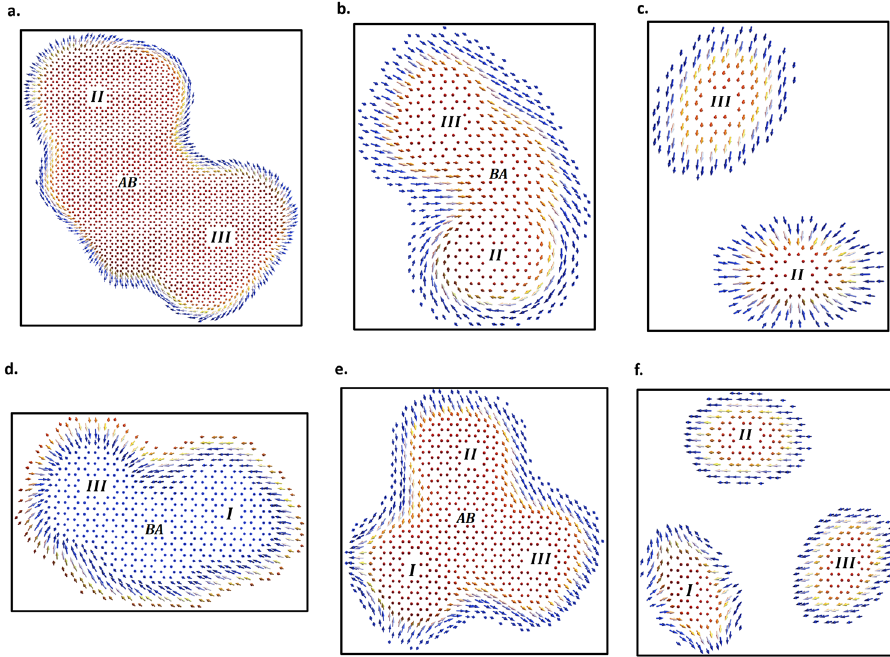
Fig. 4 Merged spontaneous topological spin textures (TSTs) in the nonchiral Heisenberg and Heisenberg-IDMI models. a TSTs in the bottom layer of the nonchiral Heisenberg-IDMI model for twist angle θ ¼ 0 : 96 (cid:2) (IDMI stands for the intrinsic Dzyaloshinskii – Moriya interaction). The TST extends over regions II, III, and the AB-stacked ferromagnetic (FM) region. It hosts more than 2800 spins, carries a topological charge Q ¼ 3, and represents a bound state of three skyrmions with different helicities. b The nonchiral Heisenberg-IDMI model with θ ¼ 2 : 28 (cid:2) hosts a TST combining a Bloch-type skyrmion (region II) and a topologically trivial magnetic bubble (MB) in region III. Applying a magnetic fi eld (cid:3) 0 : 5 ^ z T at 0 K separates the MB and the skyrmion ( c ) while changing the skyrmion ’ s morphology to a Néel-type skyrmion. d , e TSTs in the Heis e nberg model for θ ¼ 2 (cid:2) ( d ) and θ ¼ 2 : 13 (cid:2) ( e ). They correspond to a Néel-type skyrmion merged with a topologically trivial MB ( d ), and an antiskyrmion merg e d with two topologically trivial MBs ( e ) . f The merged spin con fi guration in ( e ) can be detached by a magnetic fi eld (cid:3) 0 : 5 ^ z T at 0 K . The decoupling inverts the helicity of the antiskyrmion con fi ned to region I.